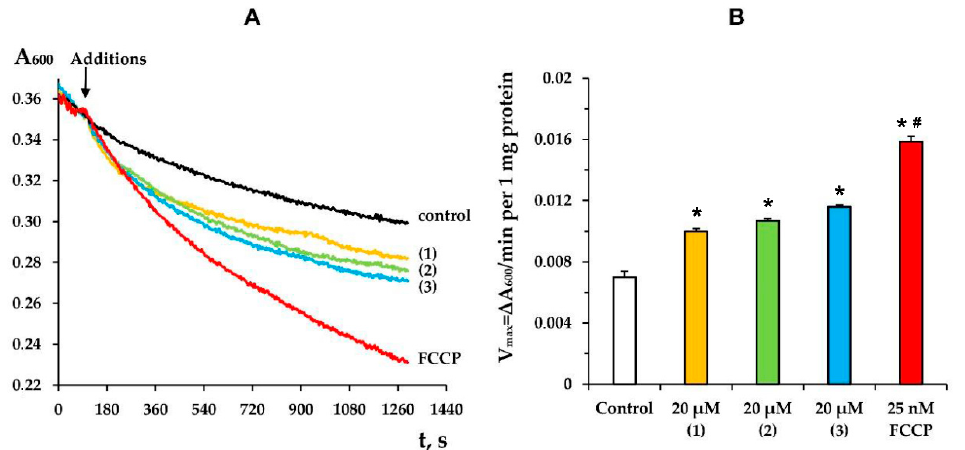
Figure 3. The kinetics ( A ) and rate ( B ) of mitochondrial swelling in NH 4 NO 3 buffer induced by 20 μ M of tested compounds or 25 nM FCCP. Control curve obtained in the absence of additions. Panel A shows typical curves recorded with the same sample during the same experiment. Similar results were observed in three other independent experiments. Panel B shows means ± SEM ( n = 4). * p < 0.05 (versus control), # p < 0.05 (versus tested compounds).